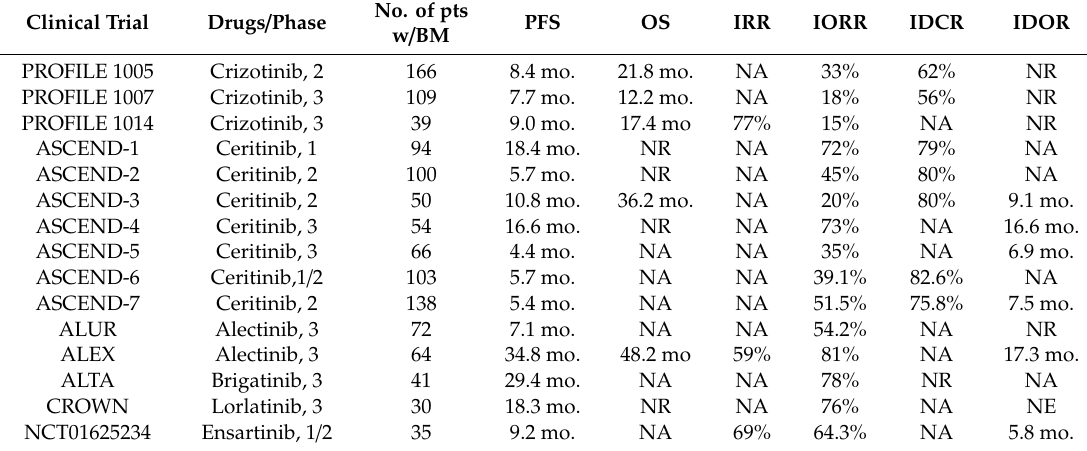
Table 2. Summary of ALK inhibitors’ e ffi cacy for brain metastases in ALK-positive treatment of naive